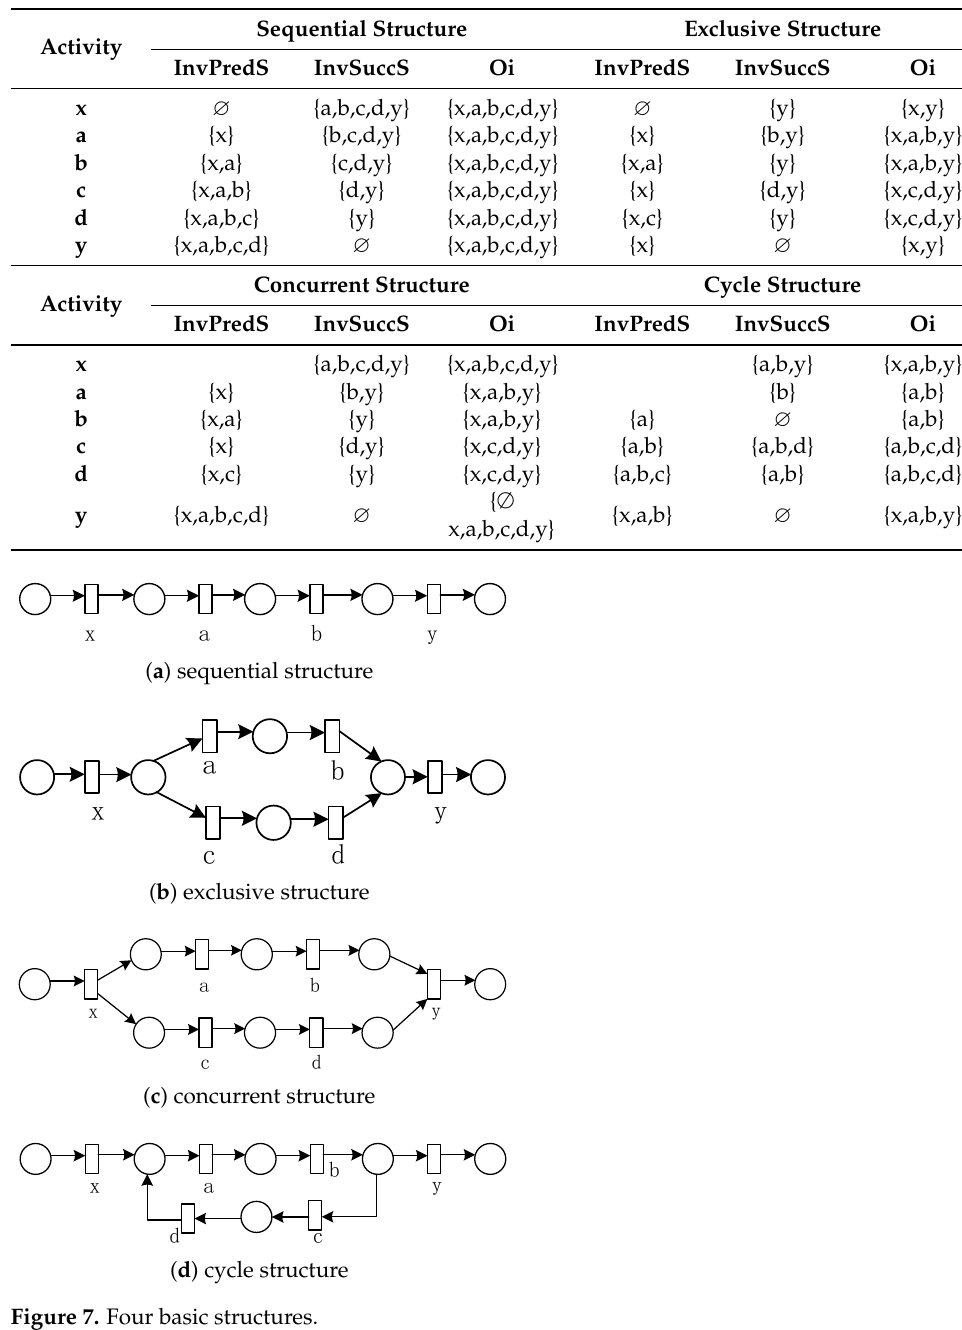
Table 6. Invariant set of activities in four basic structures.